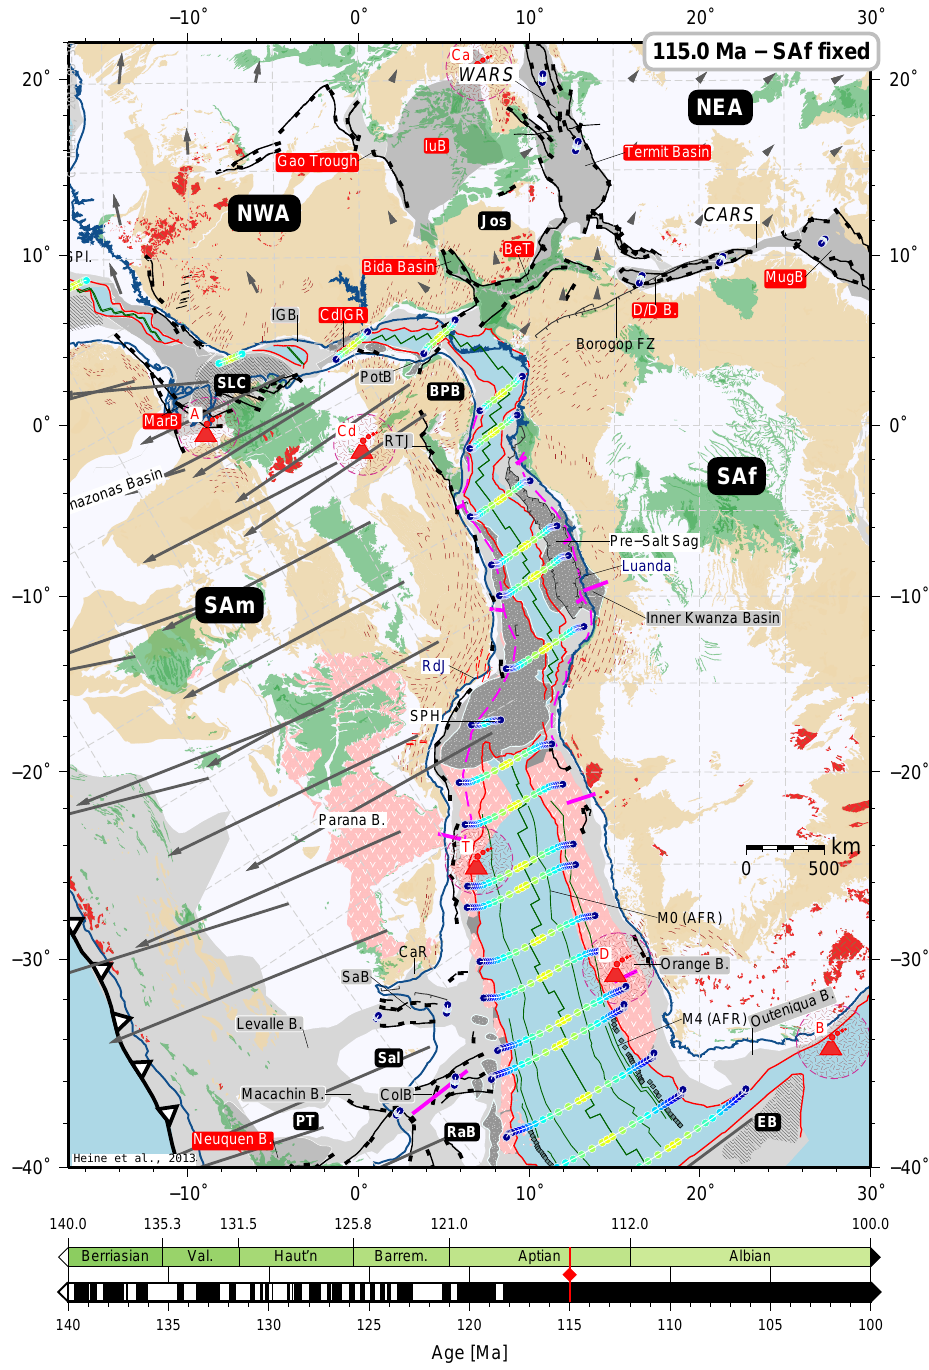
Fig. 19. Plate tectonic reconstruction at 115Ma, with Africa fixed in present-day coordinates. For map legend see Fig. 22, abbreviations as in Fig. 13. Continental break-up has occurred along most parts of the conjugate South American/southern African and NW African margins apart from the “Amazon” and Cˆote d’Ivoire/Ghana transform segment of the equatorial Atlantic. Oceanic accretion has already commenced in the Deep Ghanaian Basin. In the SARS, only the Benguela–Walvis/Santos segment have not yet broken up. In this segment, extension is focussed asymmetrically close to the African margin, east of the S˜ao Paulo High. Basins in southern South America have entered the post-rift phase, and no significant relative motions between the rigid lithospheric blocks occur in post-Barremian times. Post-rift thermal subsidence and possible gravitationally induced flow of evaporite deposits towards the basin axis occurs in conjugate margin segments of the central